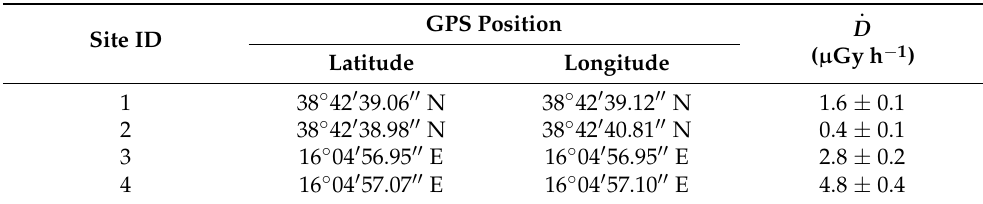
Table 1. The “hot spots” sites, together with their IDs, GPS coordinates and average values of the measured absorbed dose rate.